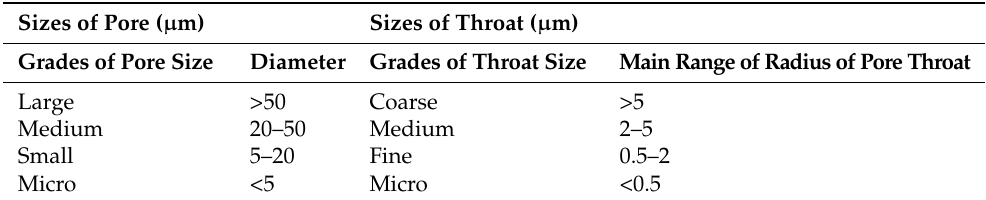
Table 4. Classification standard of the sizes of pores and pore throats in deep-mine sandstones. Sizes of Pore ( µ m) Sizes of Throat ( µ m) Grades of Pore Size Diameter Grades of Throat Size Main Range of Radius of Pore Throat Large >50 Coarse >5 Medium 20–50 Medium 2–5 Small 5–20 Fine 0.5–2 Micro <5 Micro